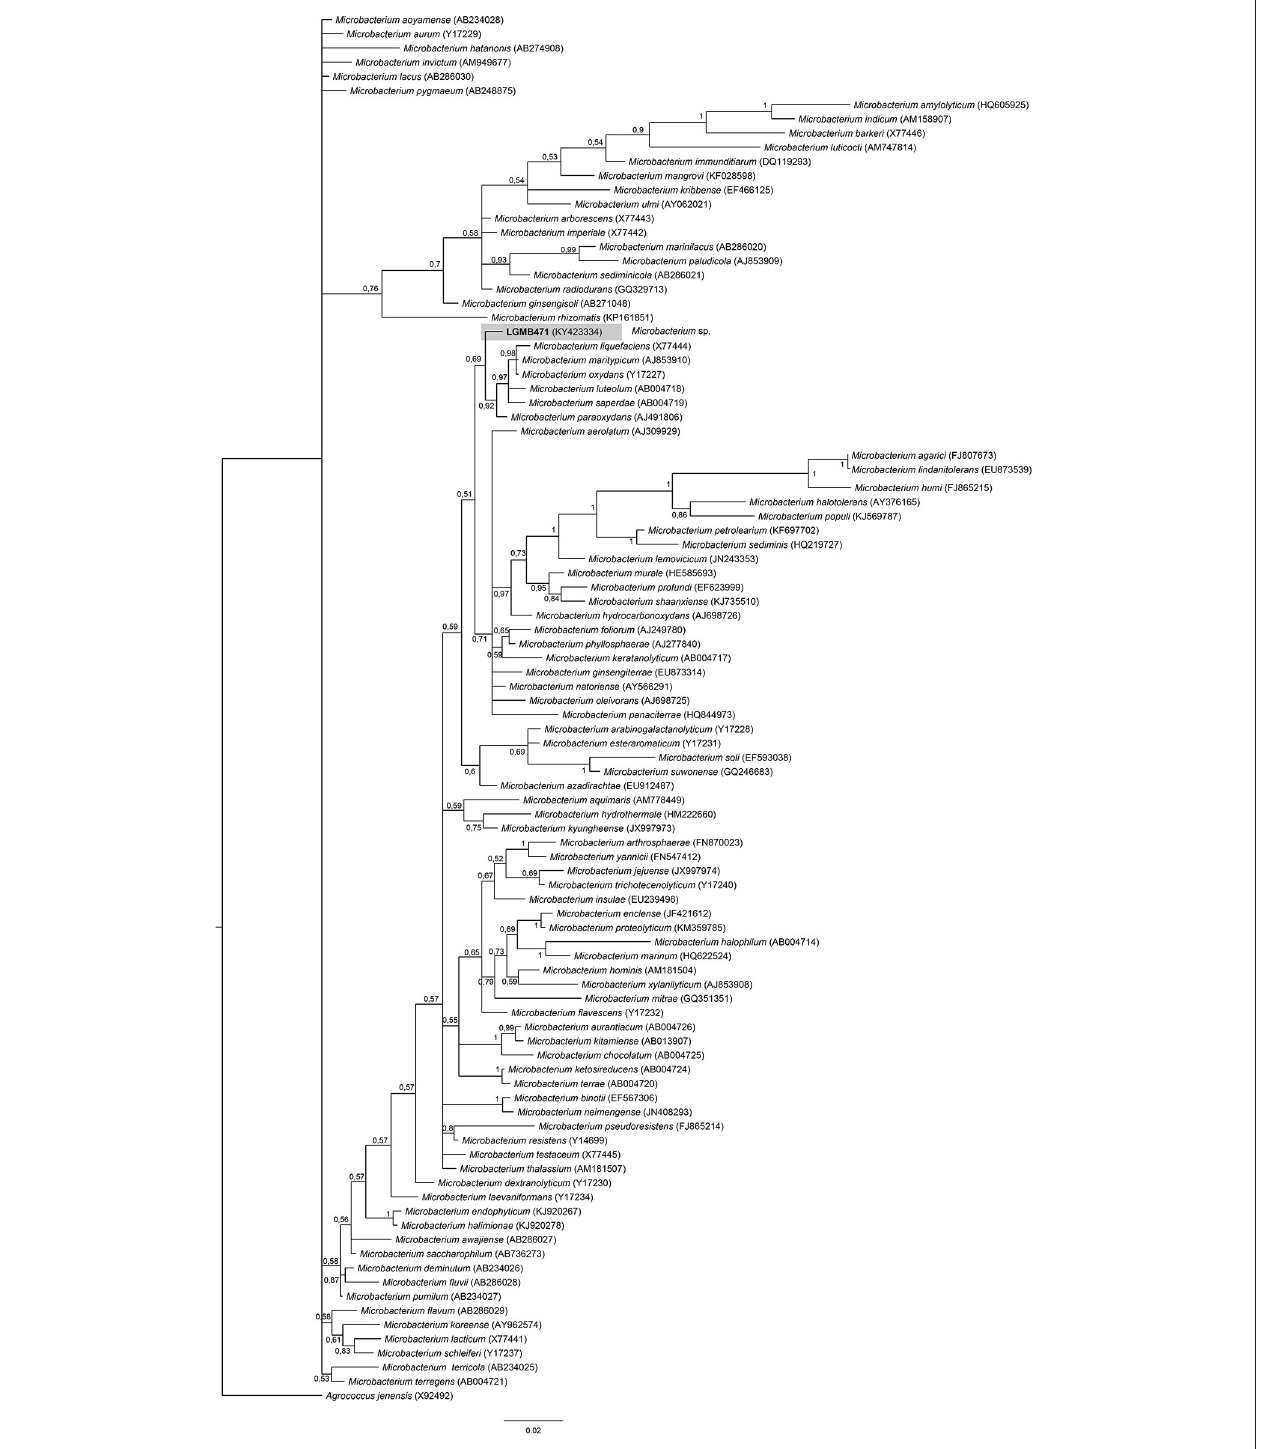
FIGURE 3 | Bayesian phylogenic tree based on 16S rRNA gene of LGMB471 and the 94 type strain of Microbacterium genus. Values on the node indicate Bayesian posterior probabilities. The species Agrococcus jenensis was used as out group. Scale bar indicates the number of substitutions per site.